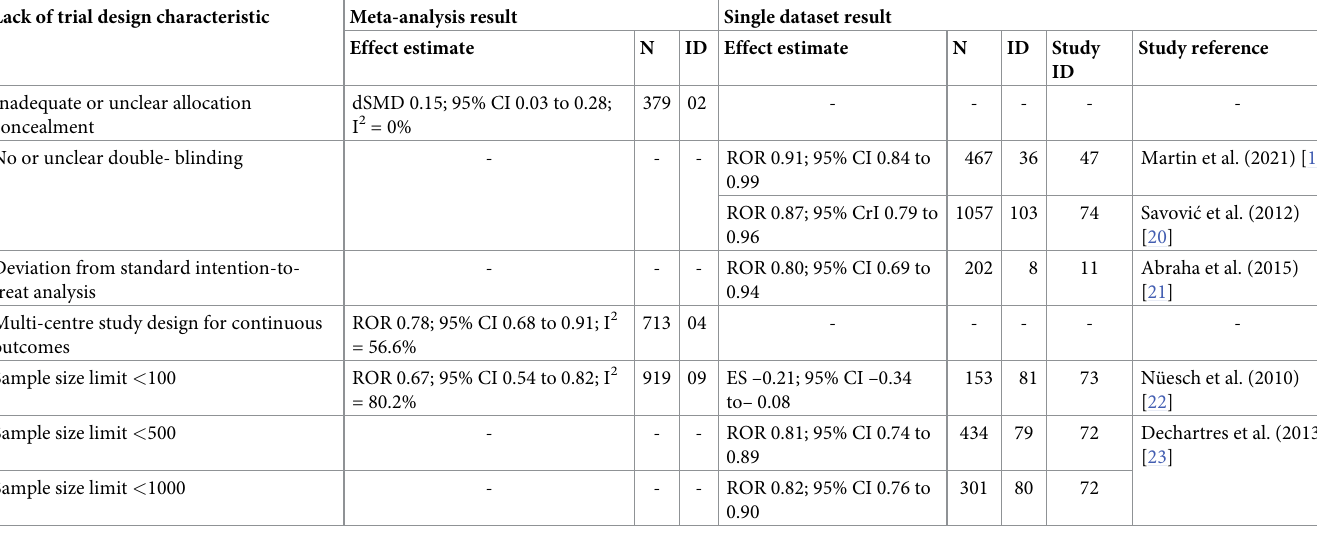
Table 1. Meta-analysis and single dataset results included for CQS extension.